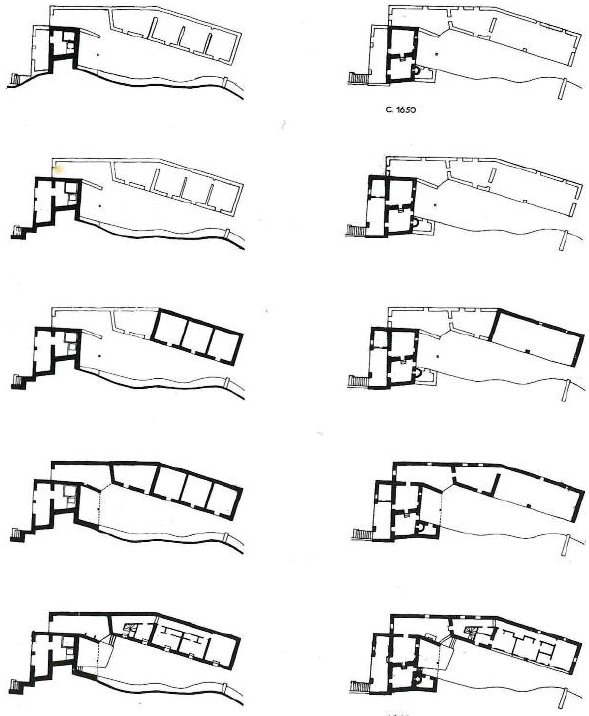
Figure 2. Growth of the building from c. 1650 to 1991 (left: ground floor; right: first floor), including Távora’s intervention as the last stage.